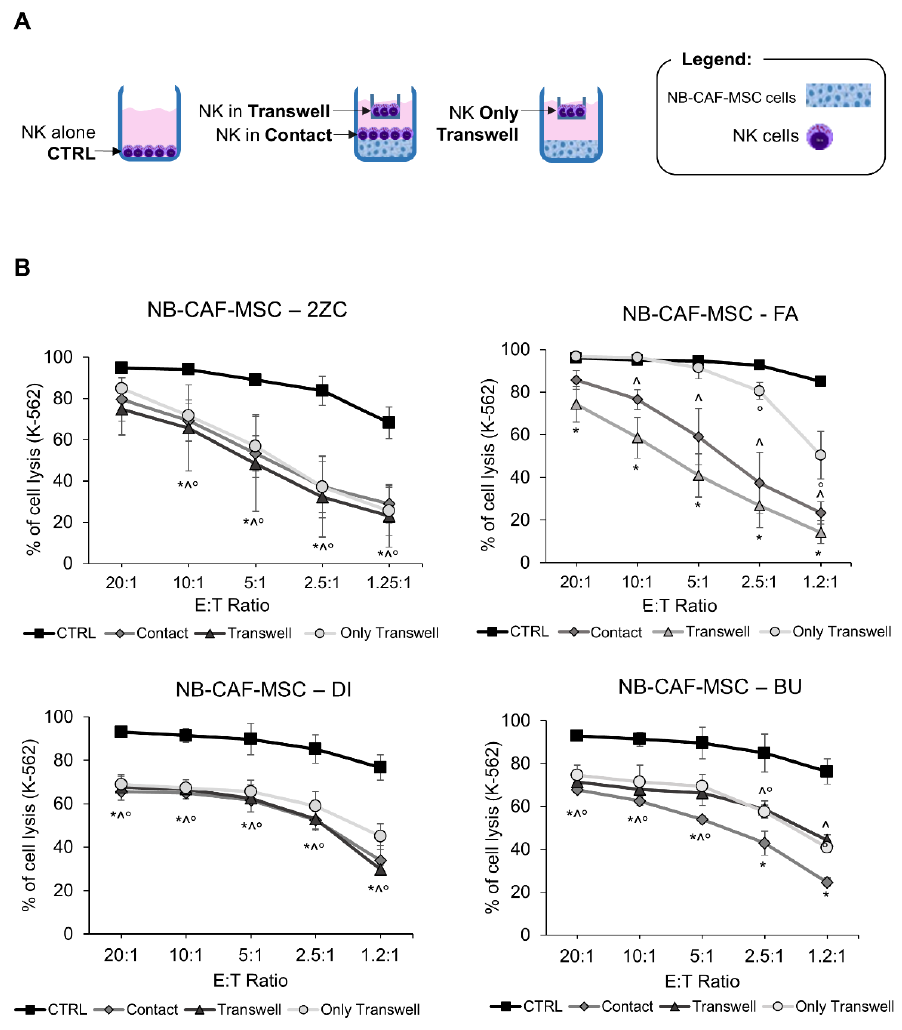
Figure 4. Evaluation of NK cell cytotoxic activity after co-culture with primary NB-TA-MSC. ( A ) Schematic representation of cells seeded in co-culture experiments. Freshly isolated NK cells were cultured in the upper chamber for 6 days with NB-TA-MSC cells in the lower chamber (Only Transwell) or a setting with NK cells in the upper chamber (NK Transwell) and NB-TA-MSC with NK cells in the lower chamber (Contact). NK cultured alone were used as the control (CTRL). ( B ) NK cell cytotoxicity assays against CMFDA-labelled K-562 cells after co-culture with young/proliferating NB-TA-2ZC, FA, DI and BU primary cultures under direct cell–cell contact (Contact) or under Tran- swell conditions (Transwell and Only Transwell). NK cultured alone were used as a control (CTRL). Percentages of cell lysis (CMFDA+ and PI+ cells) were expressed as mean ± SD ( n = 4). * p < 0.05 Contact vs. CTRL. ˆ p < 0.05 Transwell vs. CTRL ◦ p < 0.05 Only Transwell vs.